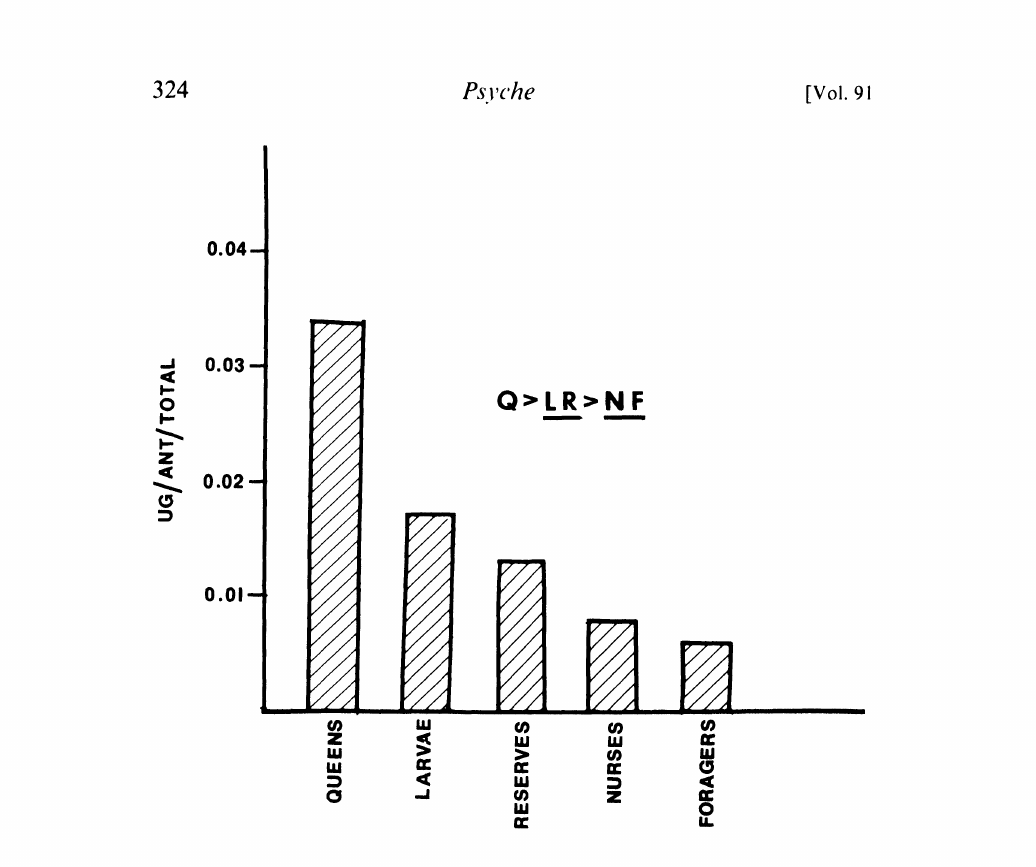
Fig. 2. The quantity of egg yolk per subcaste member is shown as a function of the amount of egg yolk in the colony. Underlined groups do not differ significantly at the p 0.05 level using the Newman-Keul Multiple Range